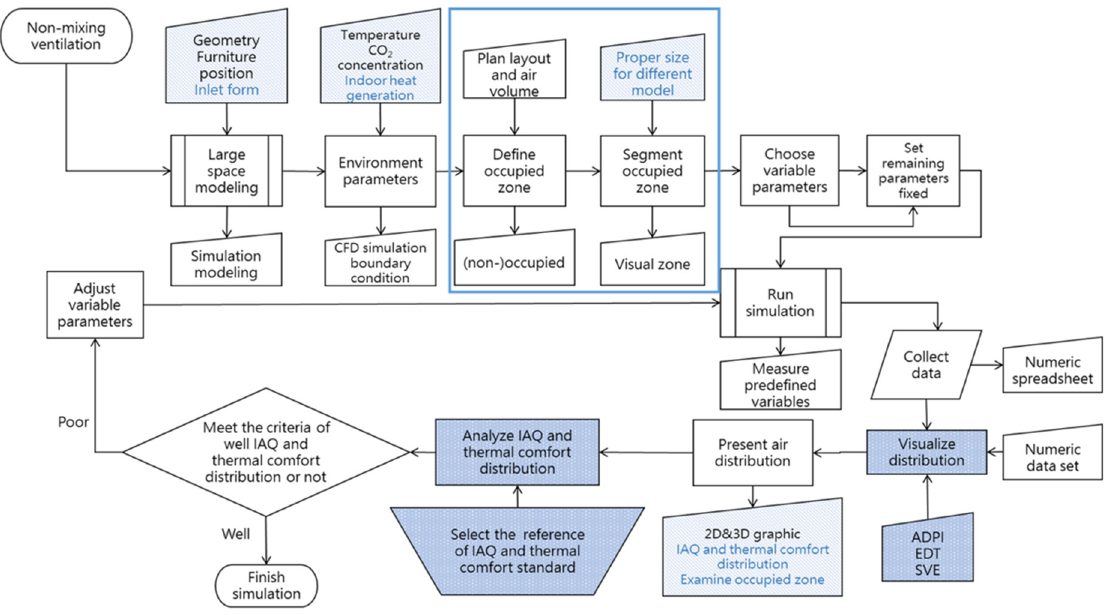
Figure 7. Improved strategy of building performance simulation for the stepped space.